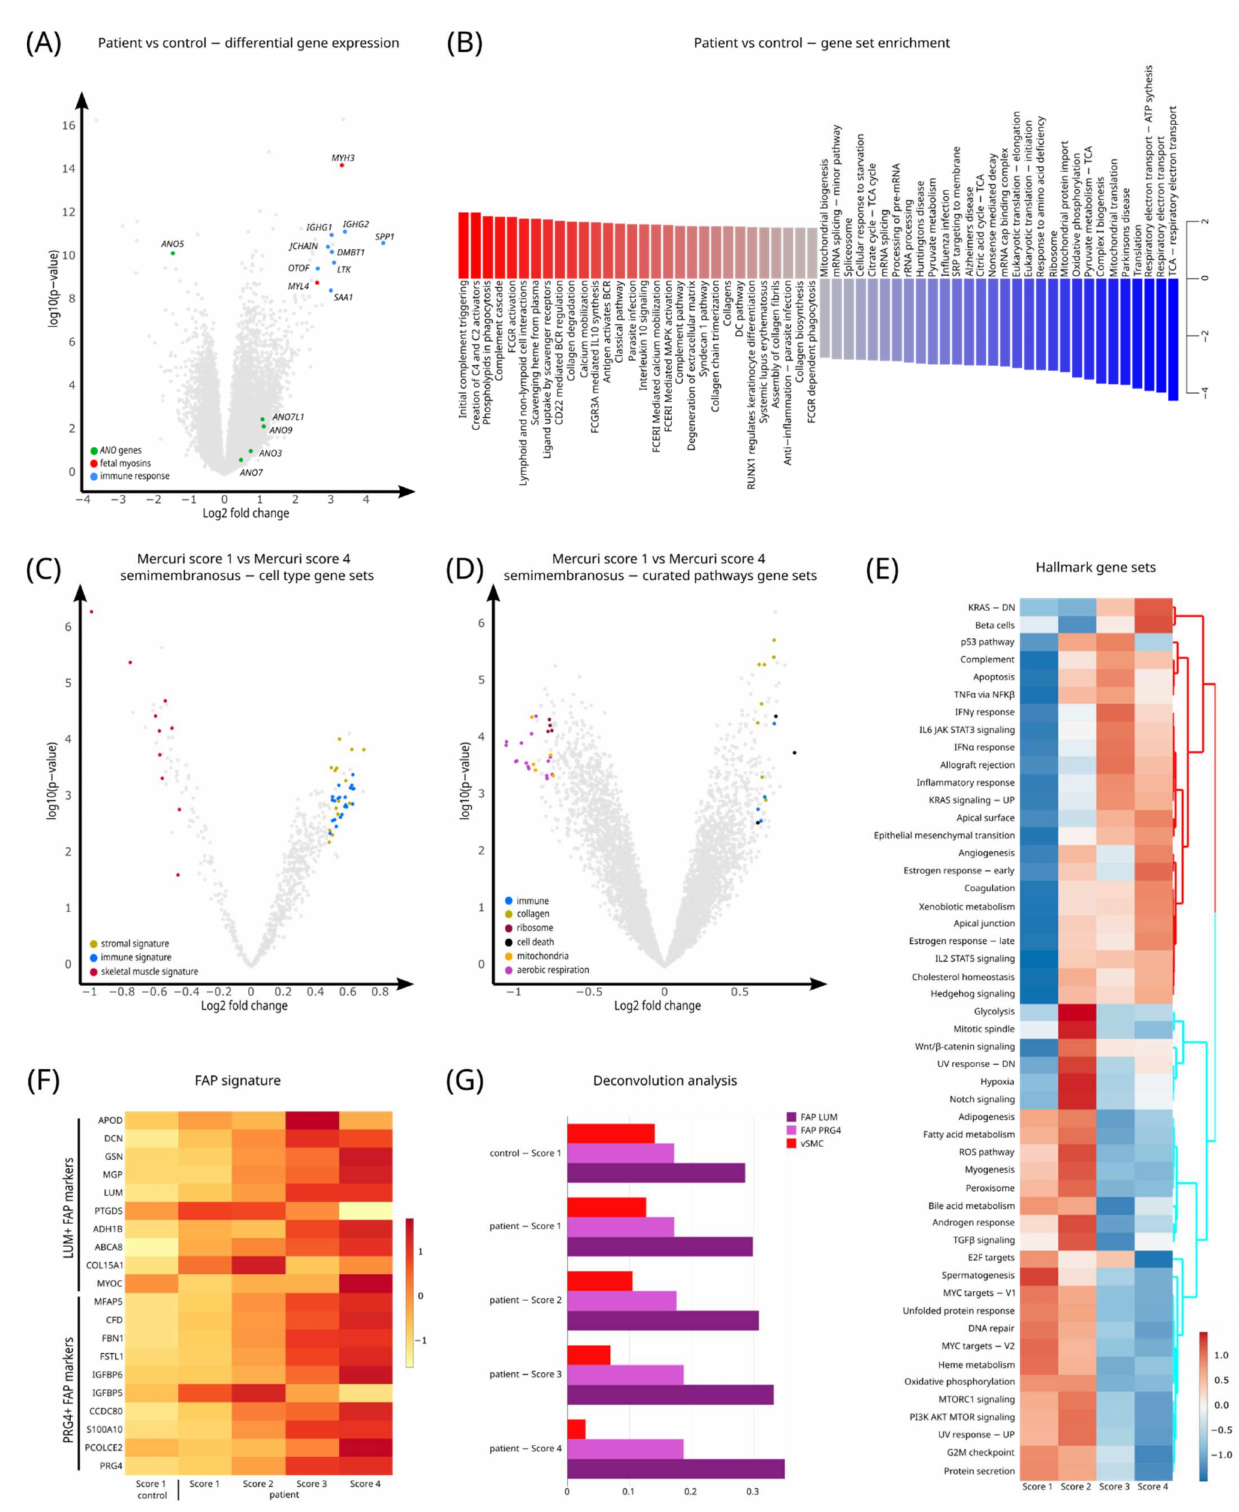
Figure 3. Gene signatures in limb-girdle muscular dystrophy R12. ( A ) Volcano plot of a differential gene expression analysis of LGMD-R12 patient versus control samples. Genes mentioned in text are highlighted in red. ( B ) Bar plot showing top enriched gene sets based on the results of differential gene expression analysis of LGMD-R12 patient versus control samples. ( C ) Volcano plot of a differential gene expression analysis of Mercuri score 1 versus Mercuri score 4 semimembranosus samples. Genes associated with immune cells, collagen production, ribosomes, cell death, mitochondria and